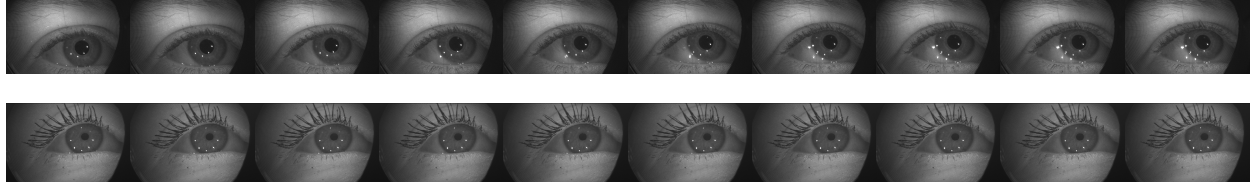
Figure 2. Example of saccadic ( top row ) and smooth pursuit ( bottom row ) eye movements during 100